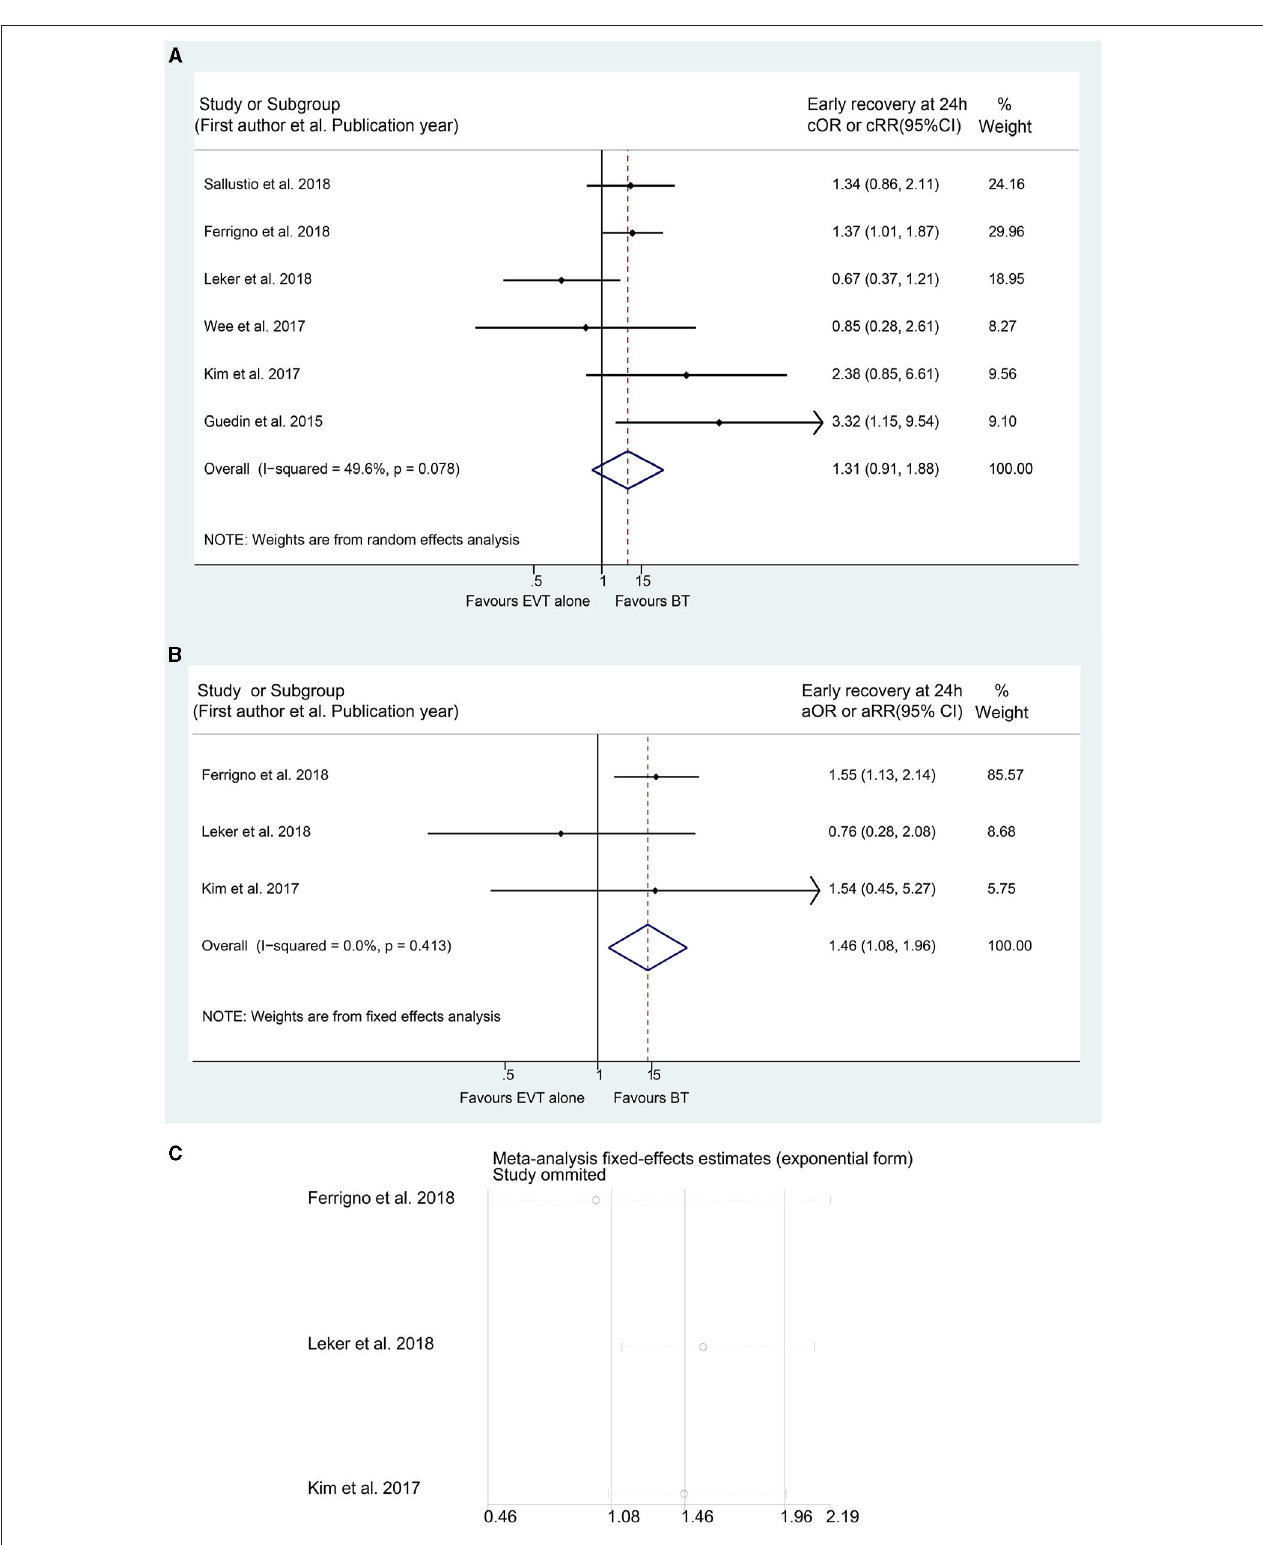
FIGURE 6 | Forest plots of studies assessing early recovery at 24h in unadjusted (A) and adjusted (B) analysis with related sensitivity analysis (C) .